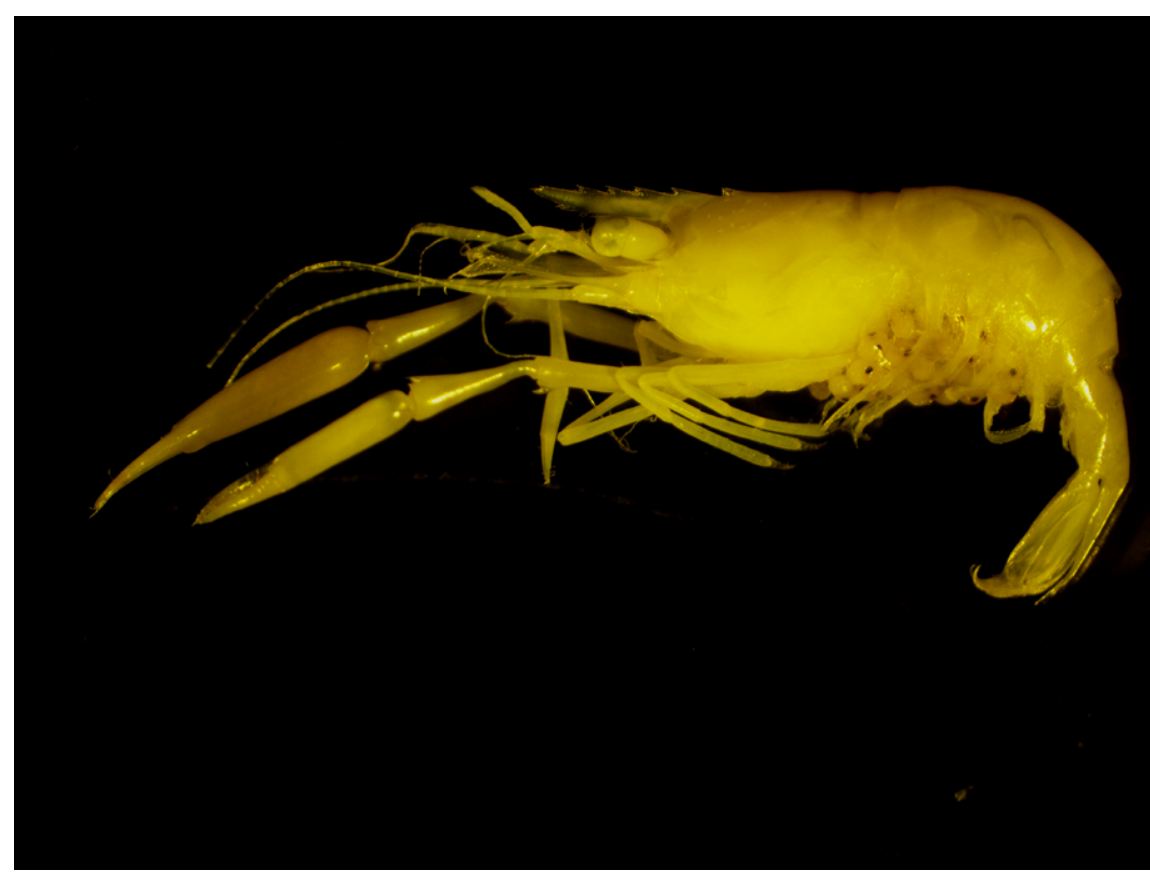
Figure 1. Preserved specimen of Palaemonella tenuipes Dana, 1852 (ID no: NBFGR: DBTLD206, female, CL 2.5 mm) from Lakshadweep Islands,